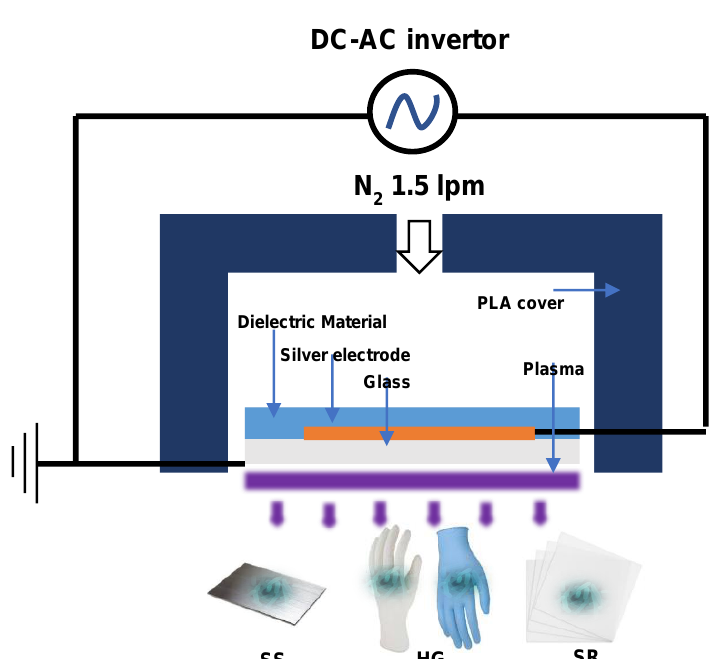
Figure 5. Illustration of the DBD plasma used in our study. Direct current (DC), alternating current (AC), Polylactic acid (PLA).